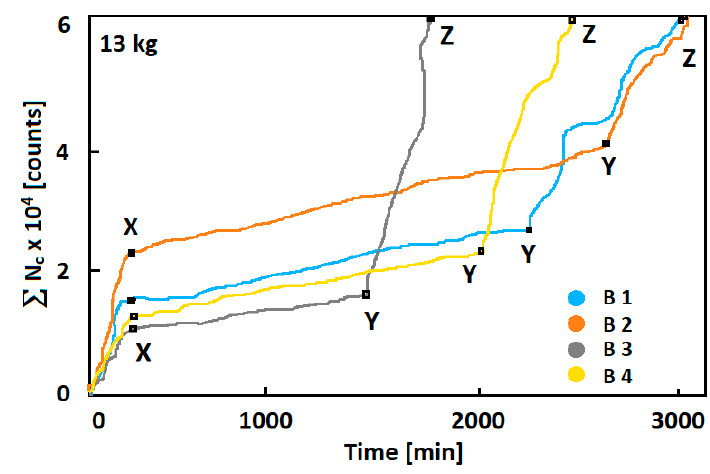
Figure 11. Summation of records of the number of AE overshoots (counts) in the course of contact fatigue tests of clad deposits.